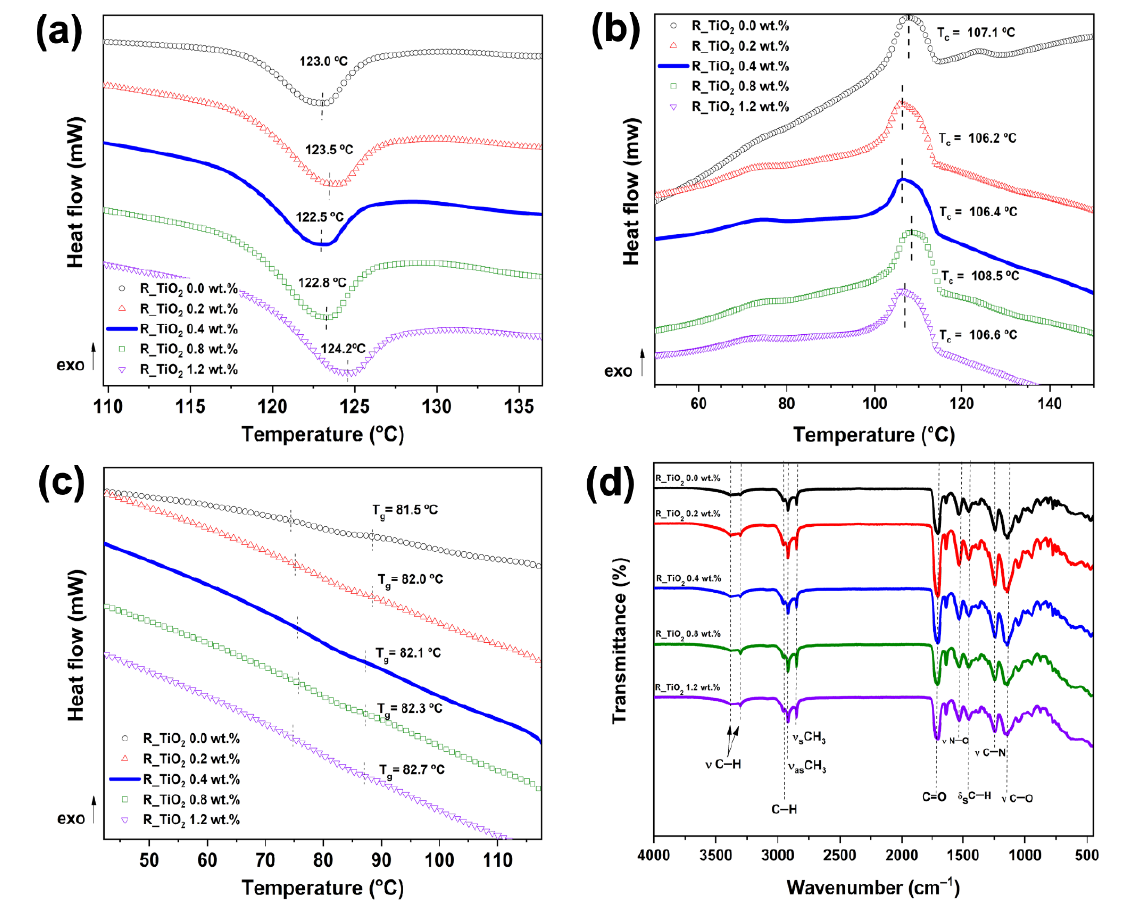
Figure 2. Thermal and chemical characterization corresponding to 3D-printed polymer nanocomposites: ( a ) glass transition temperature (T g ), ( b ) crystallization temperature (T c ), ( c ) melting temperature (T m ), and ( d ) ATR-FTIR.